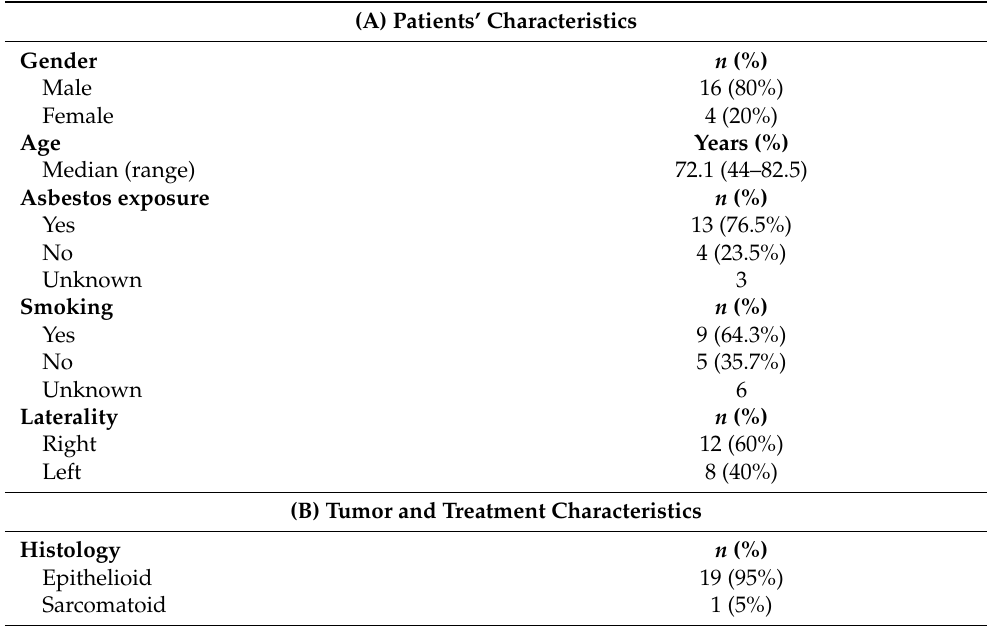
Table 1. ( A ) Patients’ characteristics and ( B ) tumor